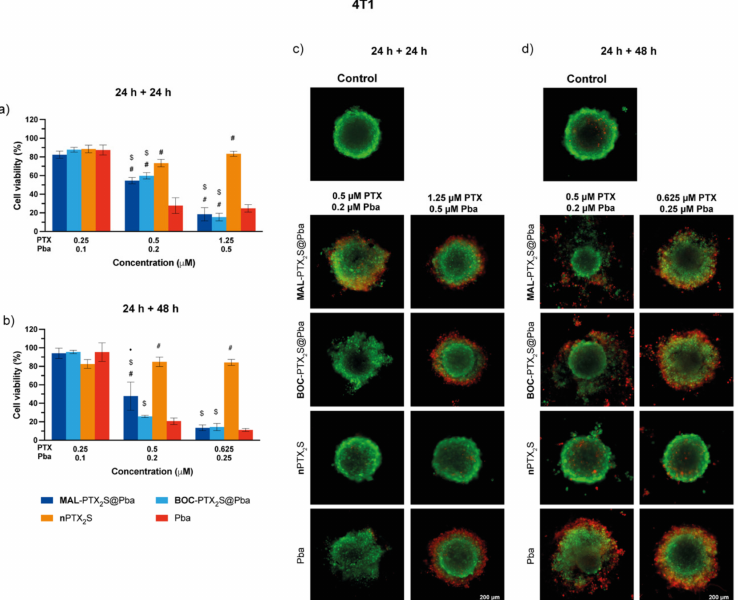
Figure 9. In vitro mono and combination therapy in 4T1 spheroids. The spheroids were incubated with the different drugs/combinations for 24 h and then irradiated with red light (1 J/cm 2 ); cell viability was measured by means of ATP reduction (3D Glo assay) 24 ( a ) or 48 h ( b ) post-irradiation. Data are expressed as mean percentage ± SD of at least two independent experiments, carried out in quadruplicate. Statistical significance was calculated applying the ANOVA Two-way with Bonferroni’s correction: • significantly different from BOC -PTX 2 S@Pba; # significantly different from Pba; $ significantly different from nPTX 2 S. Selected images of spheroids stained with the LIVE/DEAD kit and acquired 24 ( c ) or 48 h ( d ) after irradiation. Scale bars: 200 µ